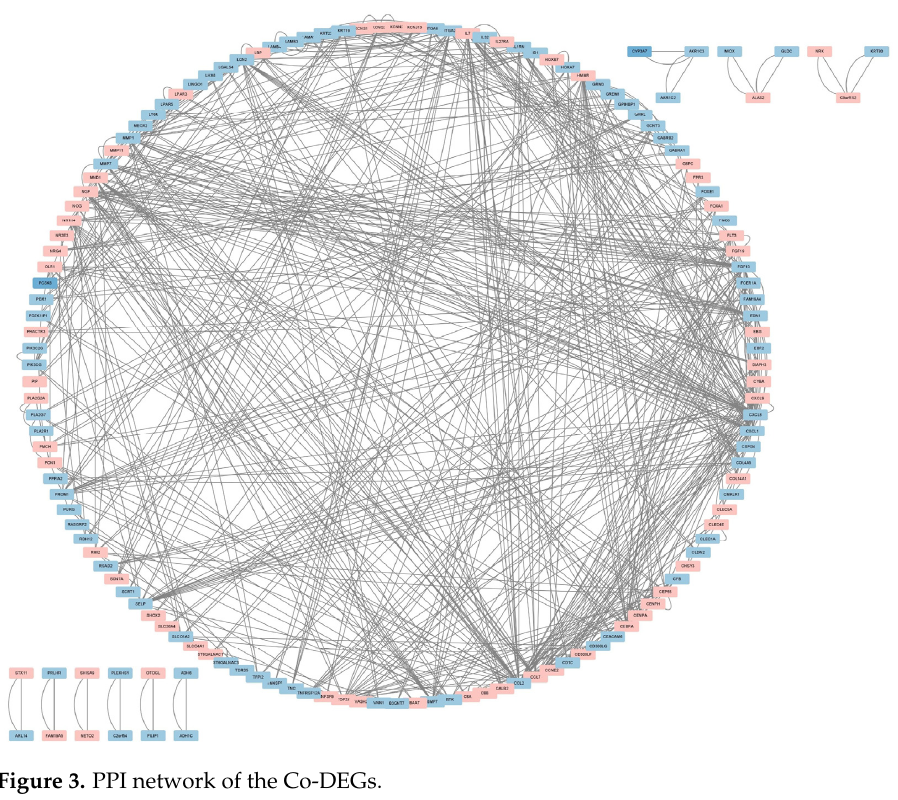
Figure 3. PPI network of the Co ‐ DEGs.